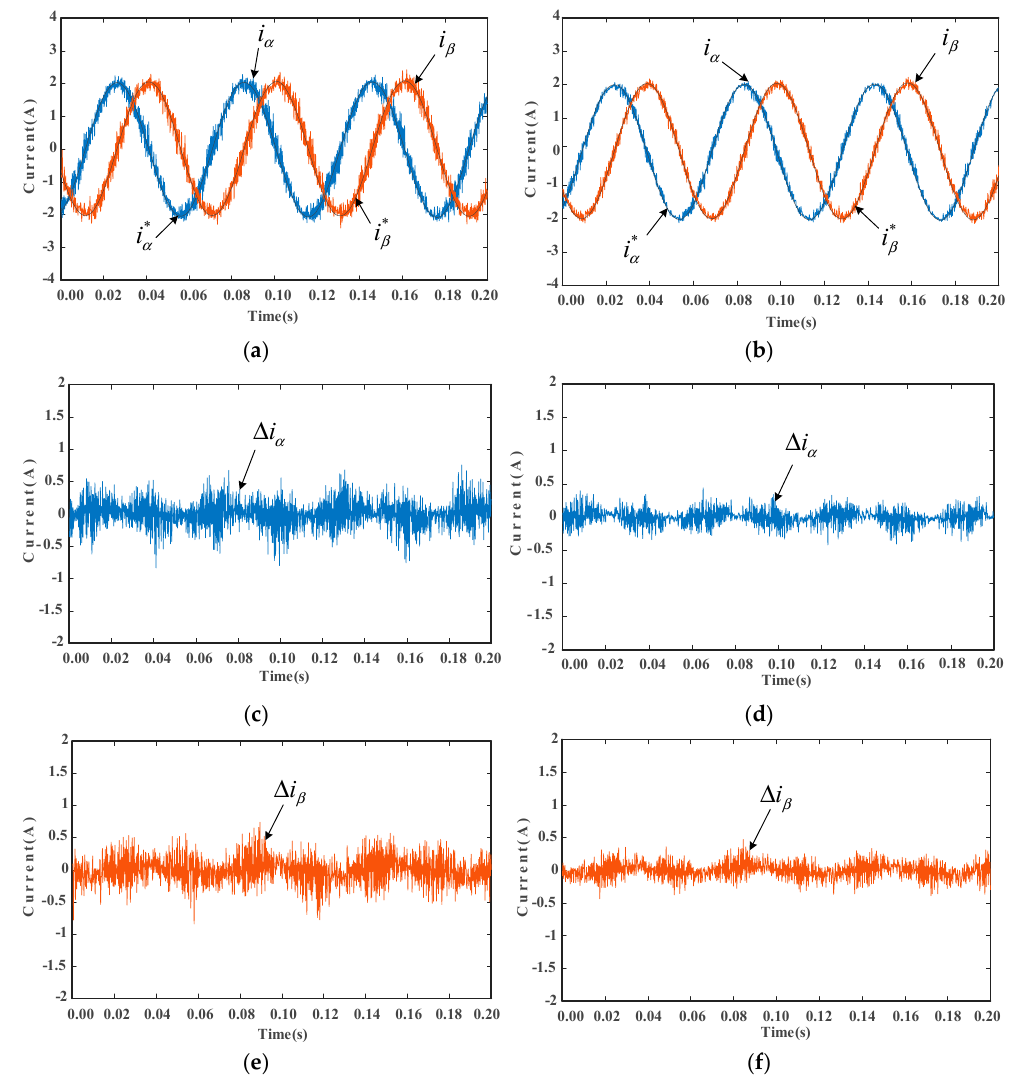
Figure 12. Currents and current errors under constant motor speed of 500 rpm and load-torque 1 N-m: ( a ) current responses of the MPCC without modulation, ( b ) current responses of the proposed MMPCC, ( c ) the α -axis current error of Figure 12a, ( d ) the α -axis current error of Figure 12b, ( e ) the 𝛽 -axis current error of Figure 12a, and ( f ) the 𝛽 -axis current error of Figure 12b.